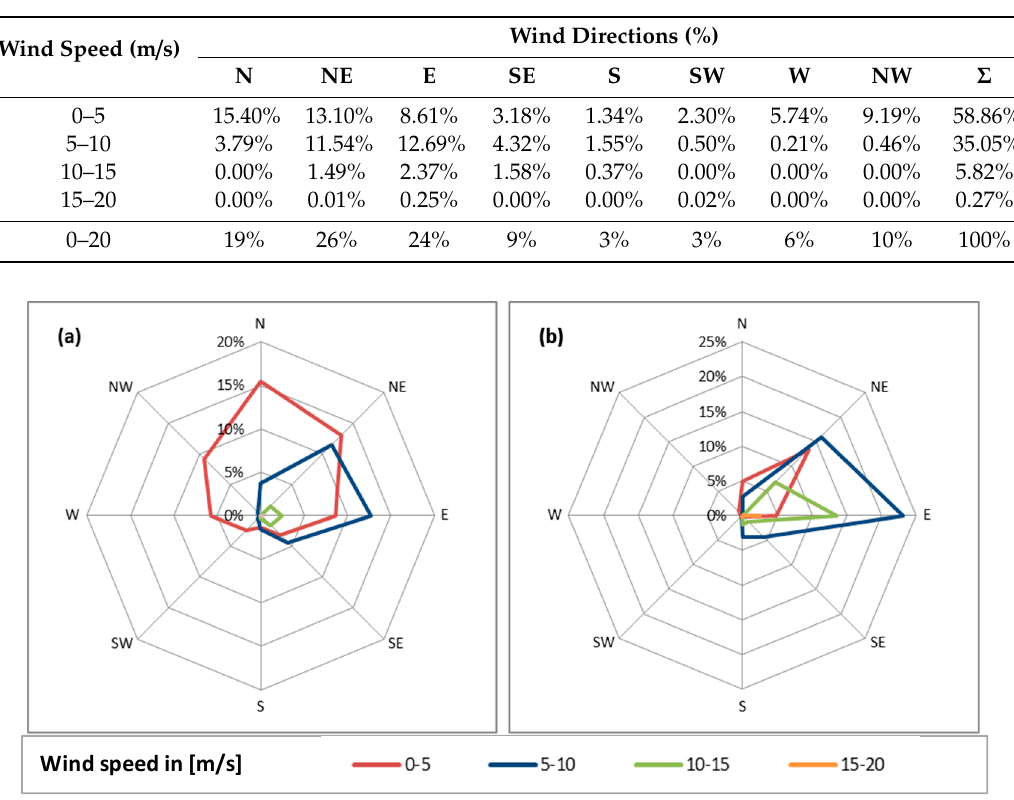
Figure 6. Wind rose for the winter season 2010/2011 ( a ) and for the calibration period 1 – 12 February ( b ); data from https://dane.imgw.pl/.